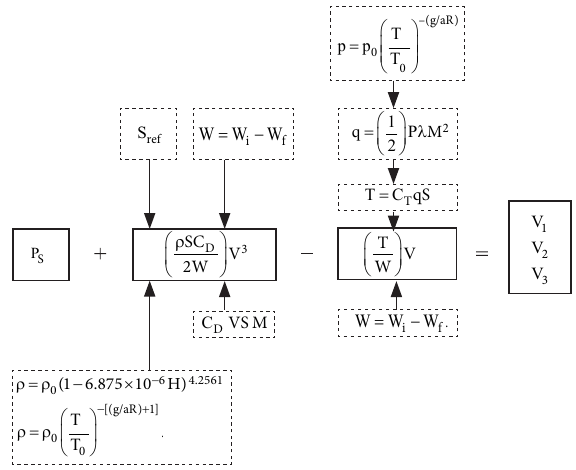
[(g/aR) 1] T T Fig. 1. Constant P S direct solution flow chart